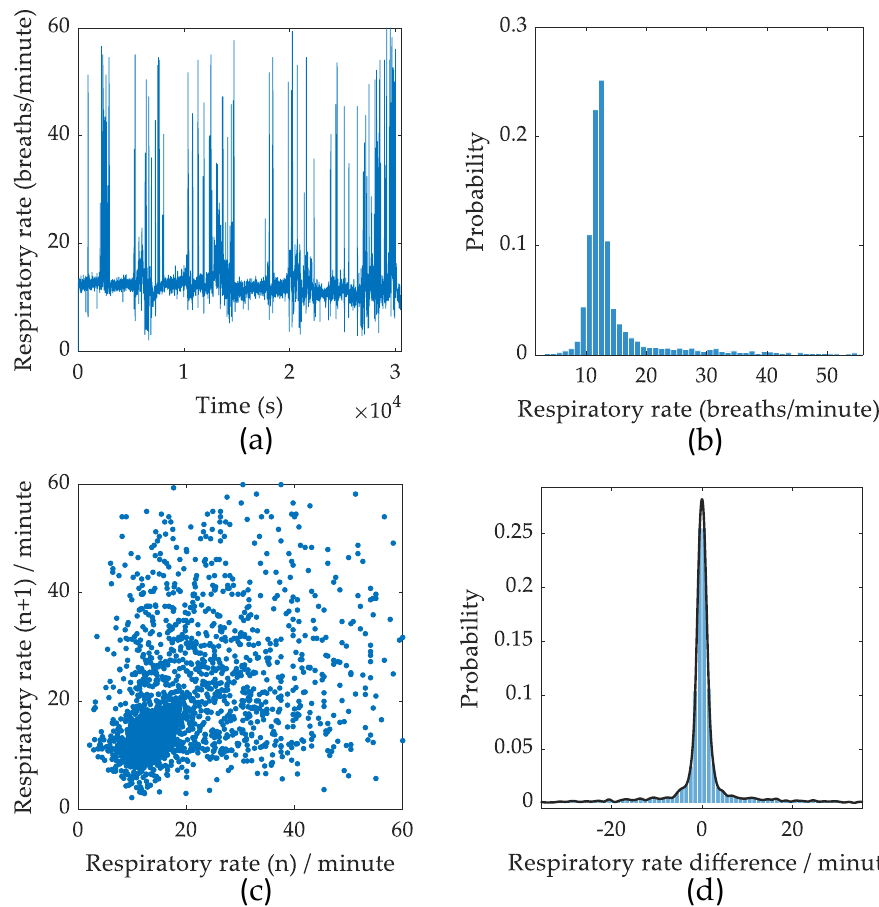
Figure A1. Respiratory rate and variability representations. ( a ) Respiratory rate. ( b ) Distribution of respiratory rate. ( c ) Poincare plot of respiratory rate variability. ( d ) Probability distribution of respiratory rate variability.